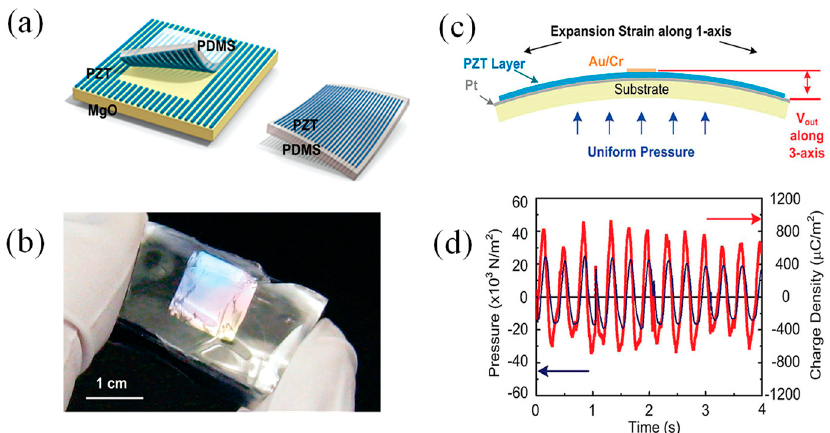
Figure 4. Transfer of PZT nanoribbons from an MgO substrate to a flexible rubber substrate. ( a ) Crystalline PZT ribbons are synthesized on an MgO host substrate, which is subsequently etched, and the ribbons are transferred and printed onto flexible PDMS rubber. ( b ) Photograph of a piece of PDMS with PZT ribbons covering the top surface. ( c ) Schematic of a specimen indicating 31-mode piezoelectric bending and measurement. The PZT layer; top and bottom contact electrodes and substrate are indicated. ( d ) Oscillating pressure (left axis) and induced dielectric displacement (right axis) [66]. Adapted with permission from Qi et al. (2010). Copyright © 2010 American Chemical